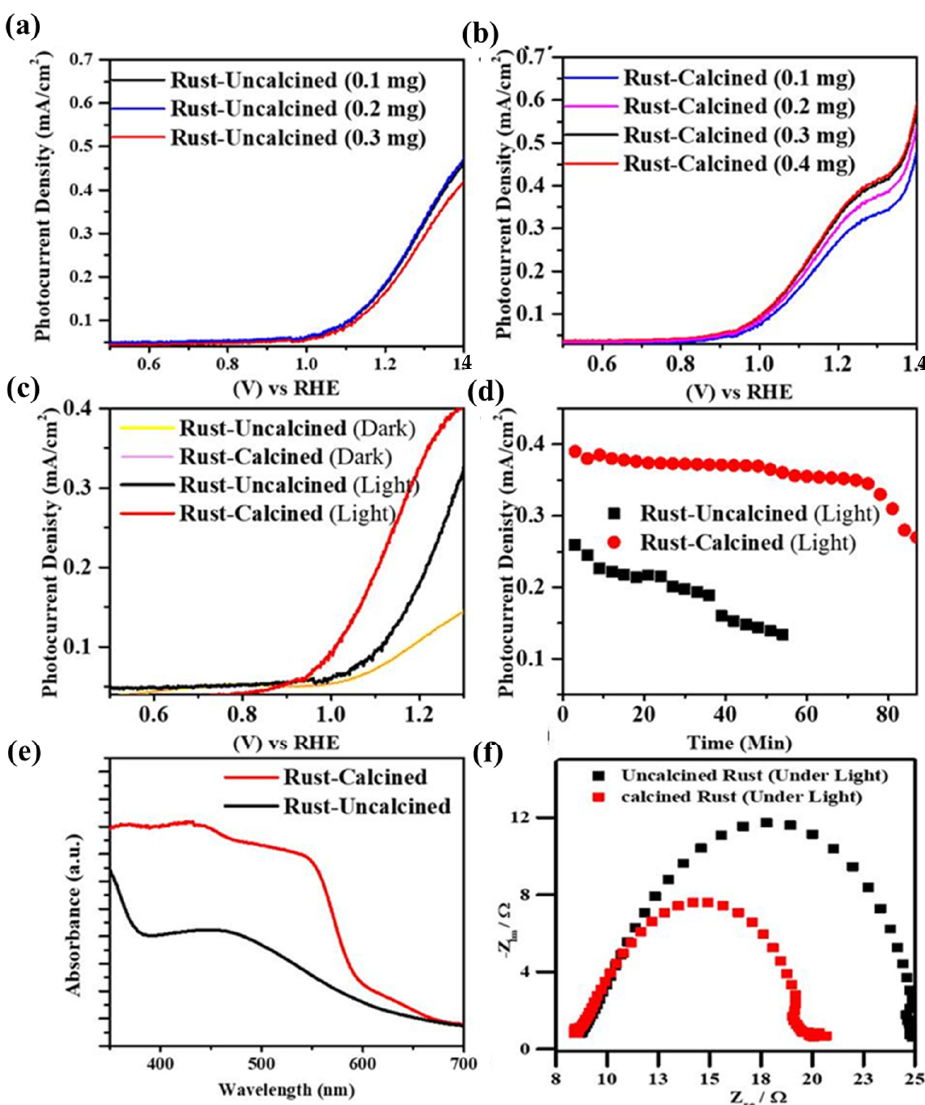
Figure 7. Photoelectrochemical measurements of calcined and uncalcined rust NPs: ( a , b ) the catalytic dose–effect under visible light, ( c ) photoelectrochemical linear sweep voltammograms, ( d ) chronoamperometric (I-t) stability curve, ( e ) the UV/Vis-DRS absorption spectra, and ( f ) the EIS Nyquist plots. 435 Table 2. Photocurrent densities and photostability of some reported hematite-based photoanodes. 436